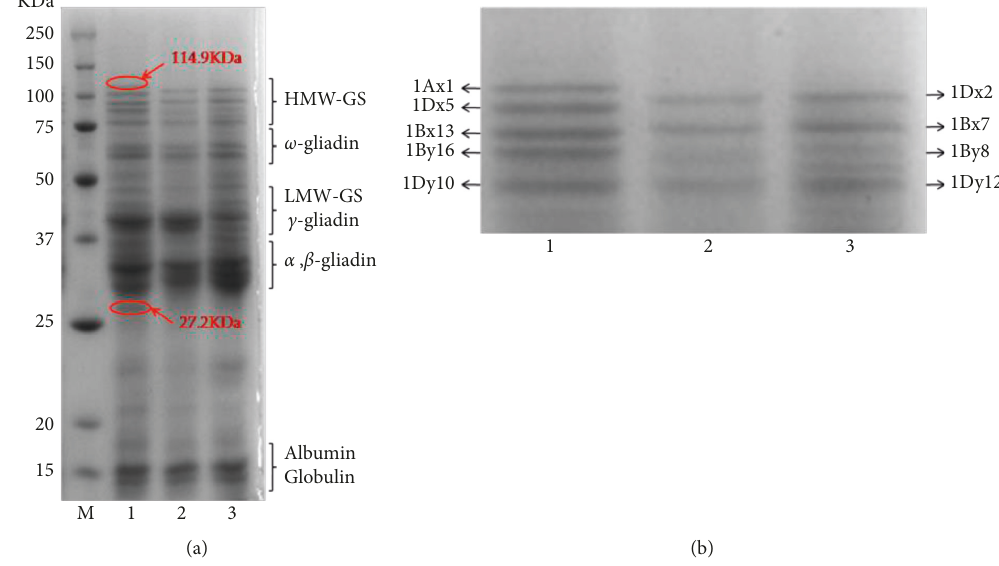
Figure 5: Reducing SDS-PAGE pattern of wheat gluten (a) and characterization of HMW-GS expressed in samples (b). Lane M marker; lanes 1–3: wheat gluten of GY2018, YM13, and SKN1,